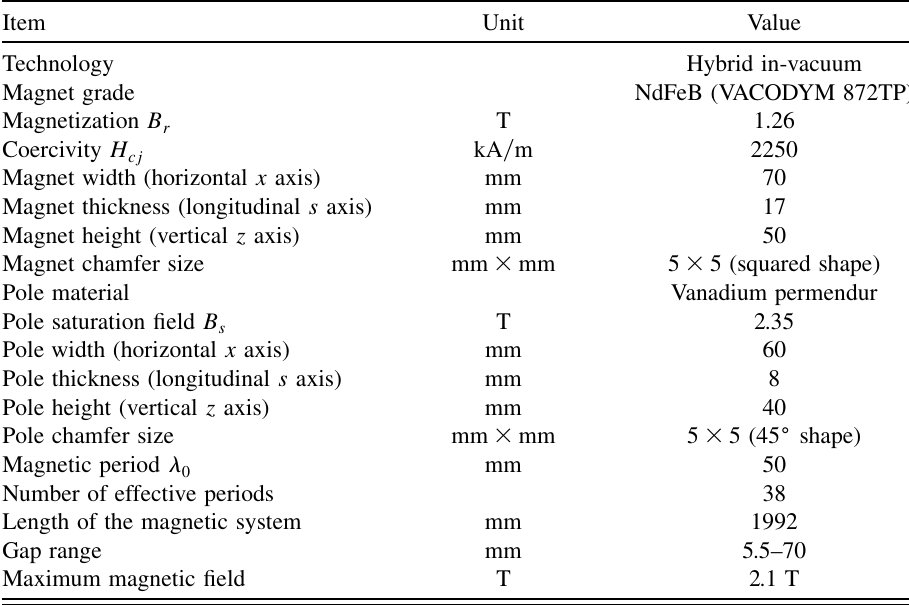
TABLE II. Characteristics of the magnetic system of WSV50.